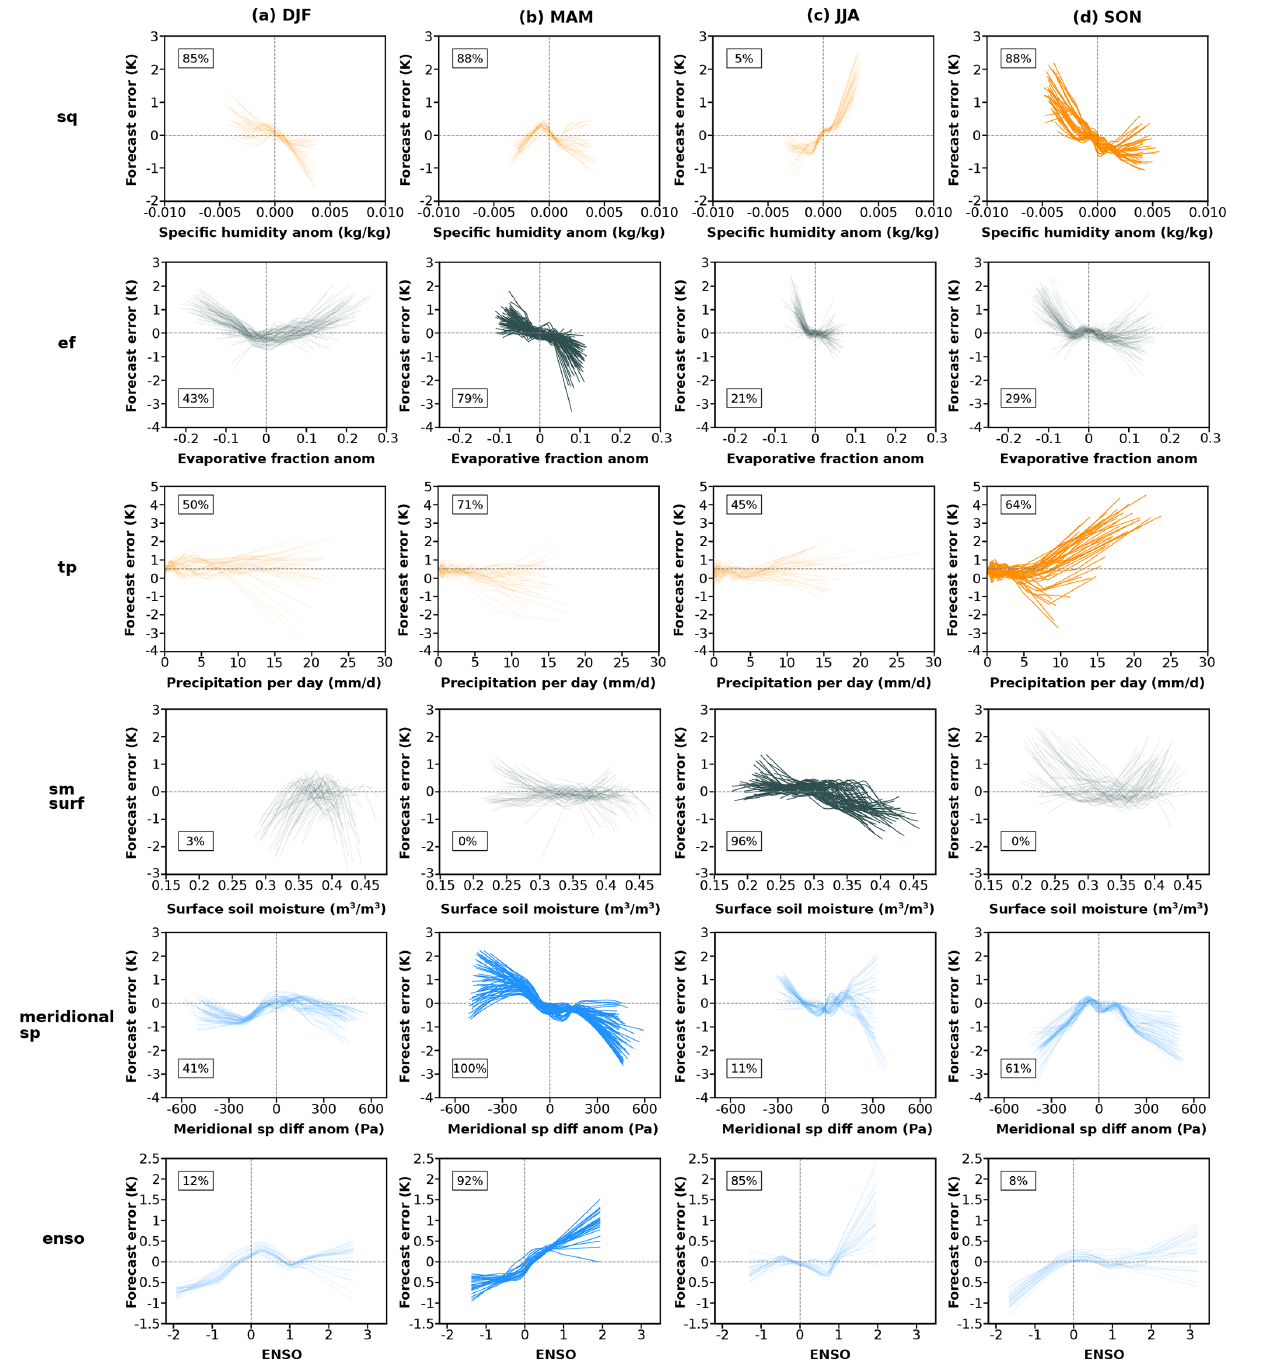
Figure 6. Relationships between the most relevant Earth system variable and forecast error in the focus regions introduced in Table 2 and Fig. 3: specific humidity region (sq), evaporative fraction region (ef), total precipitation region (tp), surface soil moisture region (sm surf), meridional surface pressure differences region (meridional sp), and ENSO region (enso) (top to bottom). Relationships are shown for all seasons as smoothing lines (loess filter) fitted to the underlying point data; each line represents the relationship at one grid pixel. Light- colored smoothing lines indicate that the variable is not the most relevant in the respective season and is only shown for completeness. Inset numbers represent the percentage of grid cells in each region with significant correlation between forecast error and the Earth system